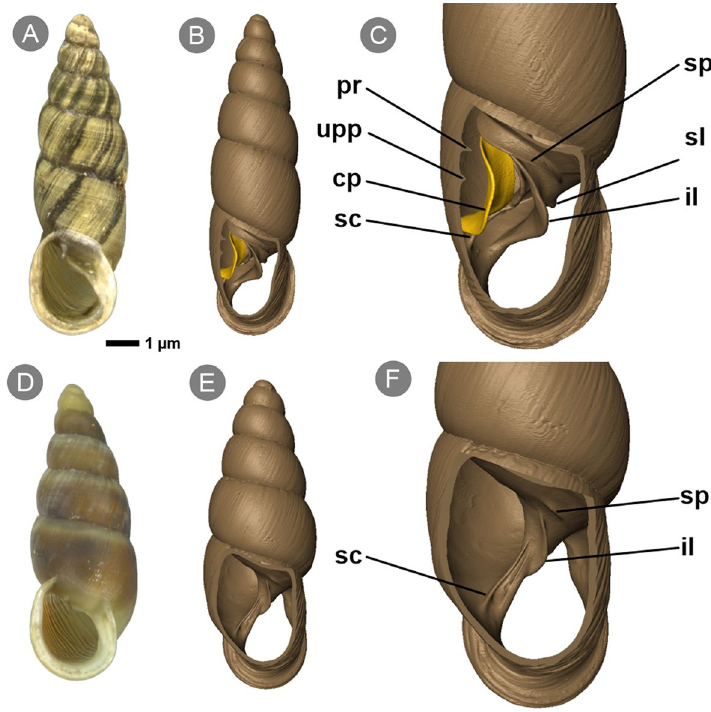
Figure 1. Different stages of reduction of apertural barriers in members of genus Reinia : R. ashizuriensis ( A–C ; upper row) and R. variegata ( D–F ; lower row). ( A,D ) Adult shells; ( B,C,E,F ) adult shells with body whorl cut open dorsally in microCT visualisation. cp clausilium plate, il inferior lamella, pr principal plica, sc subcolumellar lamella, sl superior lamella, sp spiral lamella, upp upper palatal